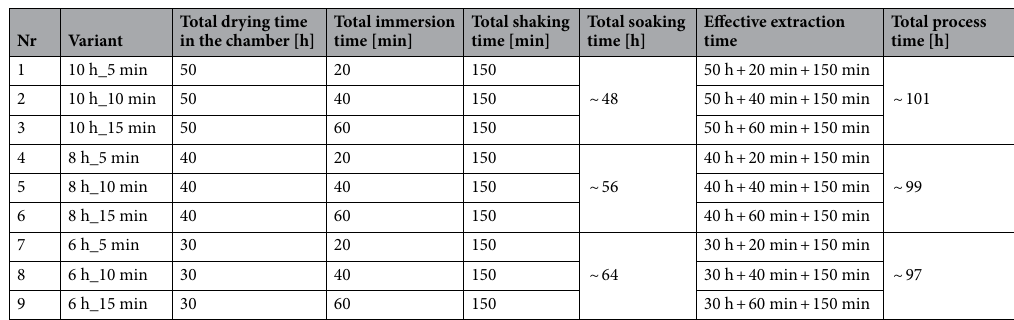
Table 1. Scope of laboratory studies of seed